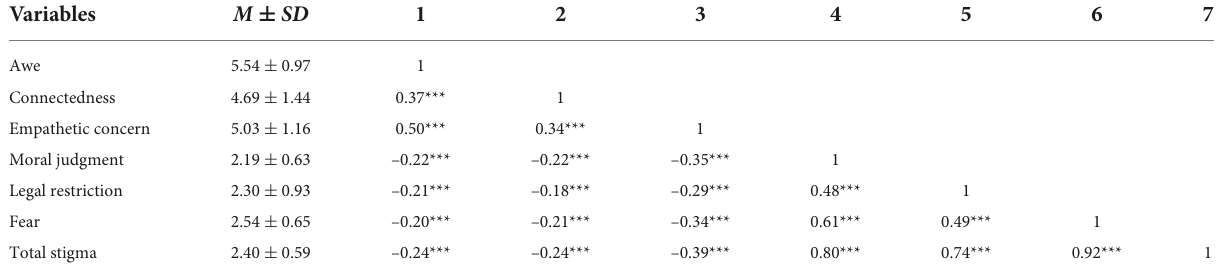
TABLE 1 Descriptive statistics and Pearson’s correlations for the variables.